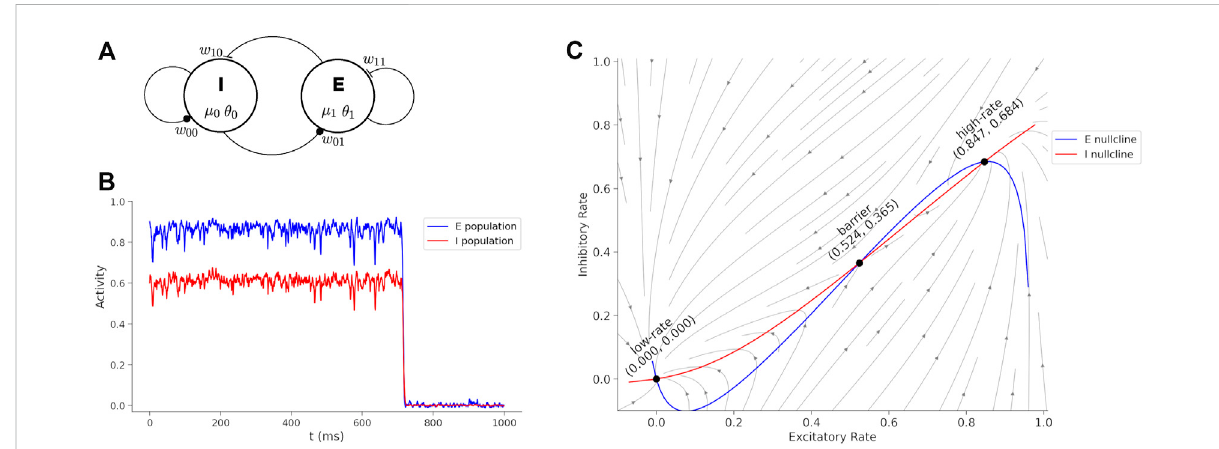
FIGURE 1 Wilson-Cowan model and dynamics. (A) Wilson-Cowan circuit with an inhibitory (I) and excitatory (E) neuron population. The model parameters associated with each circuit element are show. (B) Sustained activity eventually decays due to random perturbations drawn from a normal distribution with mean = 0 and standard deviation = 0.19. If the boundary is too high, then the sustained burst continues inde fi nitely. Treatments reduce the boundary between the states and transitions become more fl uid and interpreted as a reduction of catatoniasymptoms. (C) Phase plane of the Wilson-Cowan model with trajectories, nullclines and fi xed points